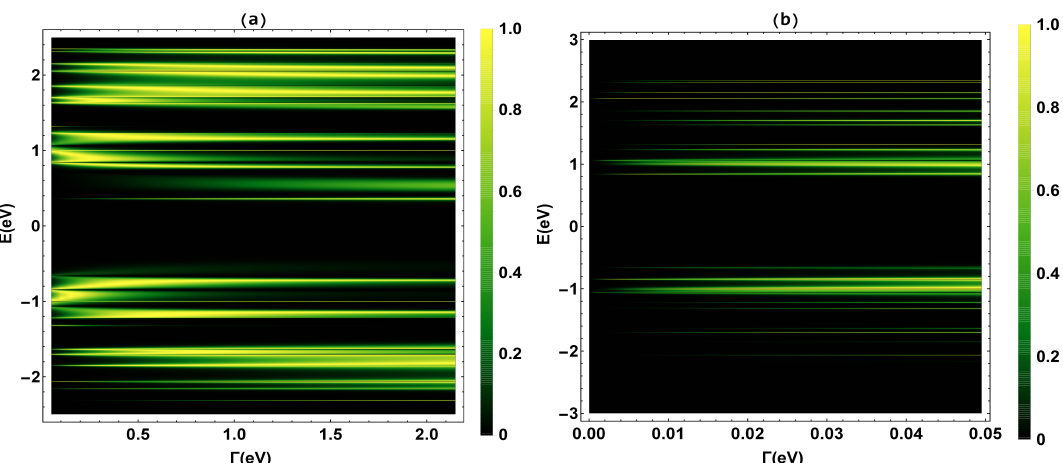
Figure 3. ( a ) Transmission probability as a function of the molecule–electrode coupling ( Γ ) and the energy ( E ). ( b ) A zoom of the transmission probability for 0.0005eV < Γ <